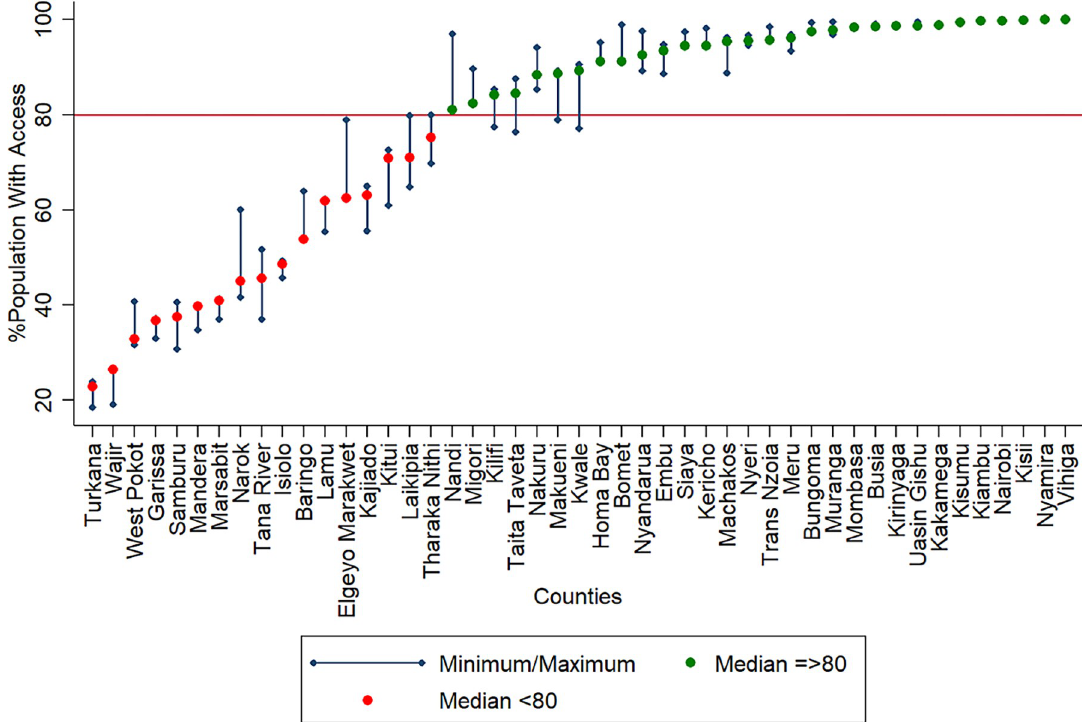
Fig 3. County-level variation in access to VLBW with the medians shown as dots. The error bars are the uncertainty intervals because of variation in access by seasons. The horizontal red line is the 80% cut-off. The counties are ordered by their median access quotients, with counties having less than 80% access shown in red and those with more than median 80% in green.